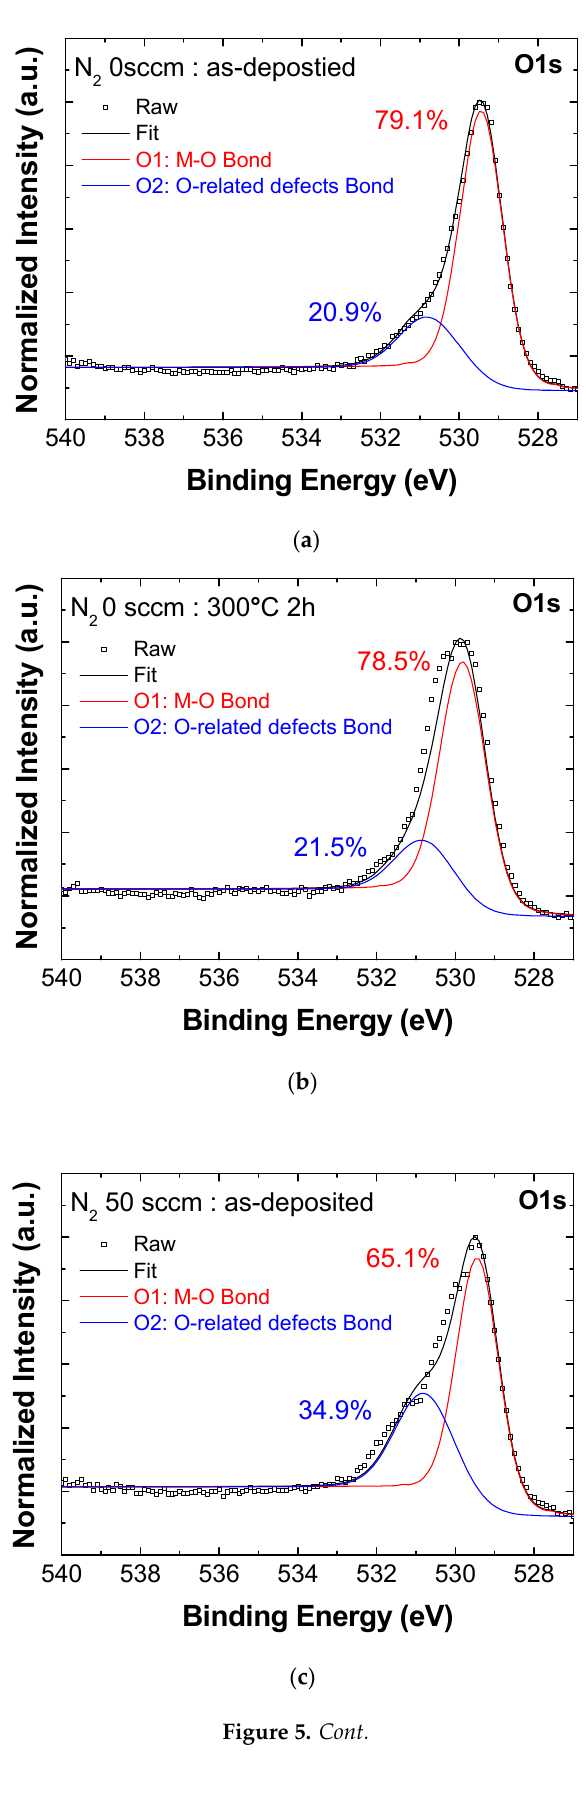
Figure 4. X-ray photoelectron spectroscopy (XPS) Cu 2p 1/2 peaks of ( a ) as-deposited Cu x O, ( b ) annealed Cu x O, ( c ) as-deposited CuON, and ( d ) annealed CuON.